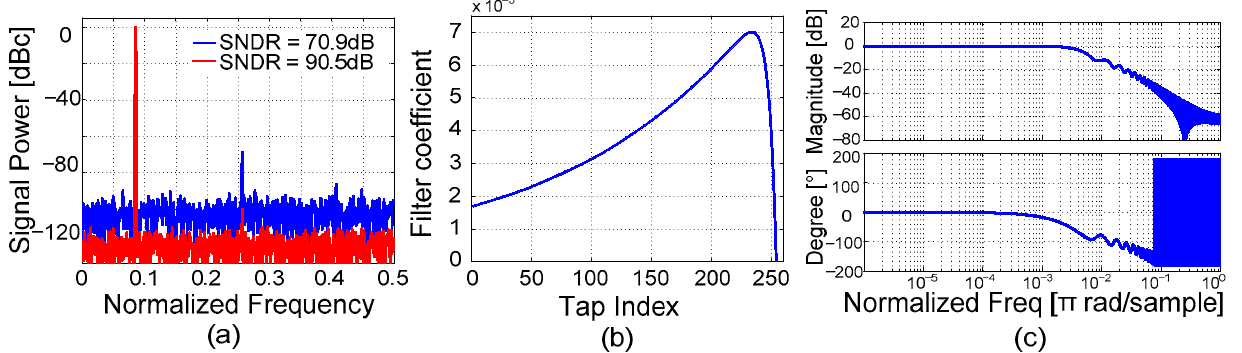
Figure 10. ( a ) Simulated output spectrum with the optimal filter (red) and the cascade-of-integrator (CoI) filter (blue) when oversampling ratio (OSR) = 256; ( b ) normalized coefficients of the filter, and ( c ) the magnitude and phase response of the filter.